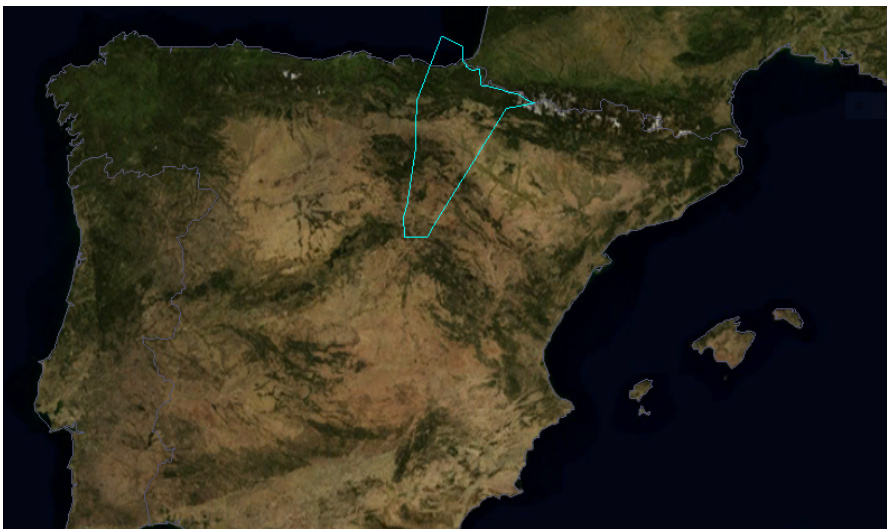
Figure 17. Pamplona Upper ATC